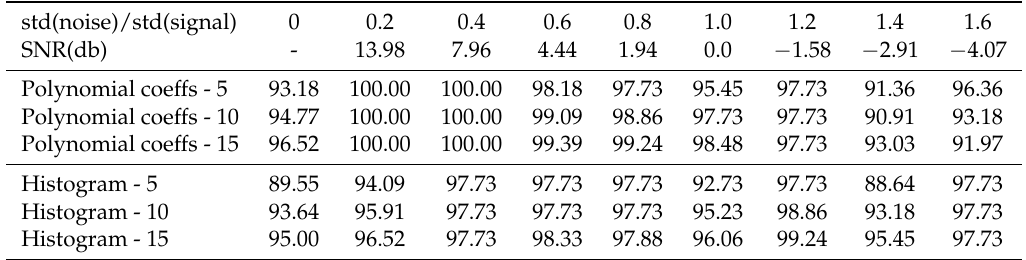
Table 4. Selecting desirable clusters with DB